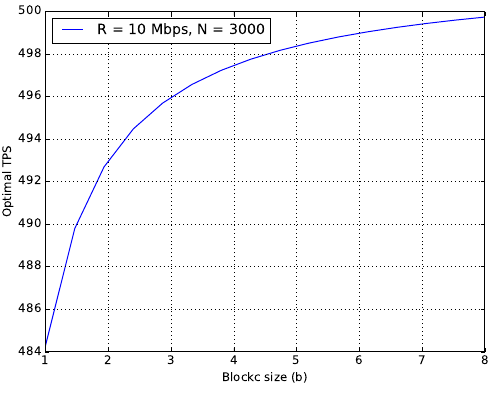
Figure 1. Block size ( b ) Vs